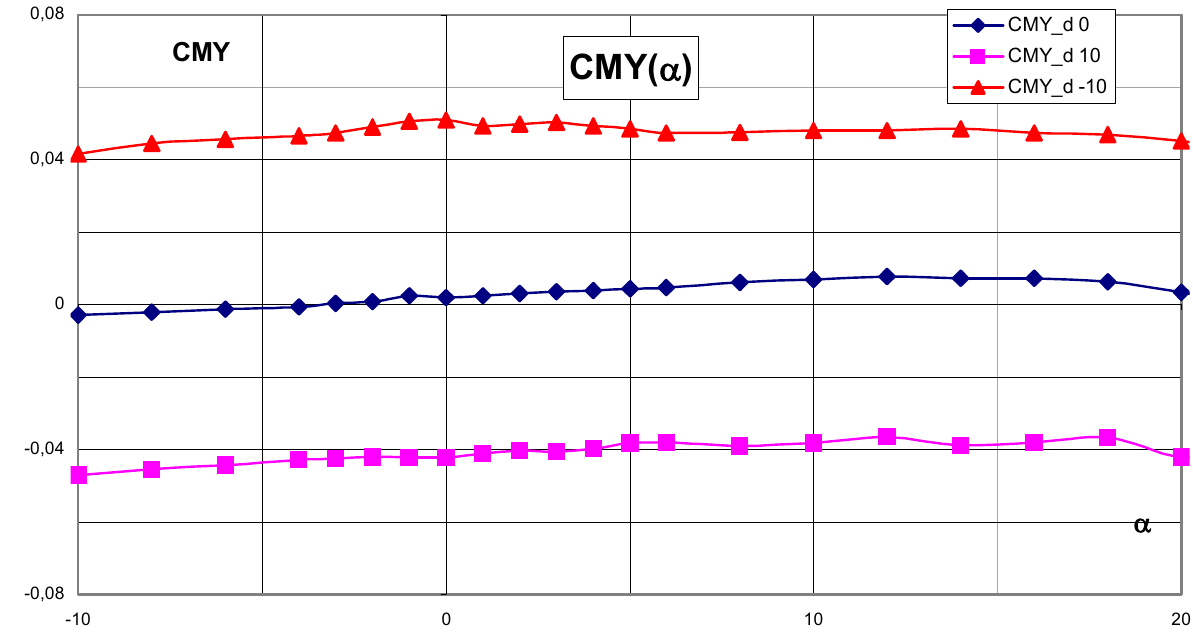
Fig 20. Pitching moment coefficient computed about a quarter point of MAC versus angle of attack for clean configuration (d=0), flap- tabs deflected down (d=10), and flap-tabs deflected up (d=-10); Ma=0.5, Re=28x10